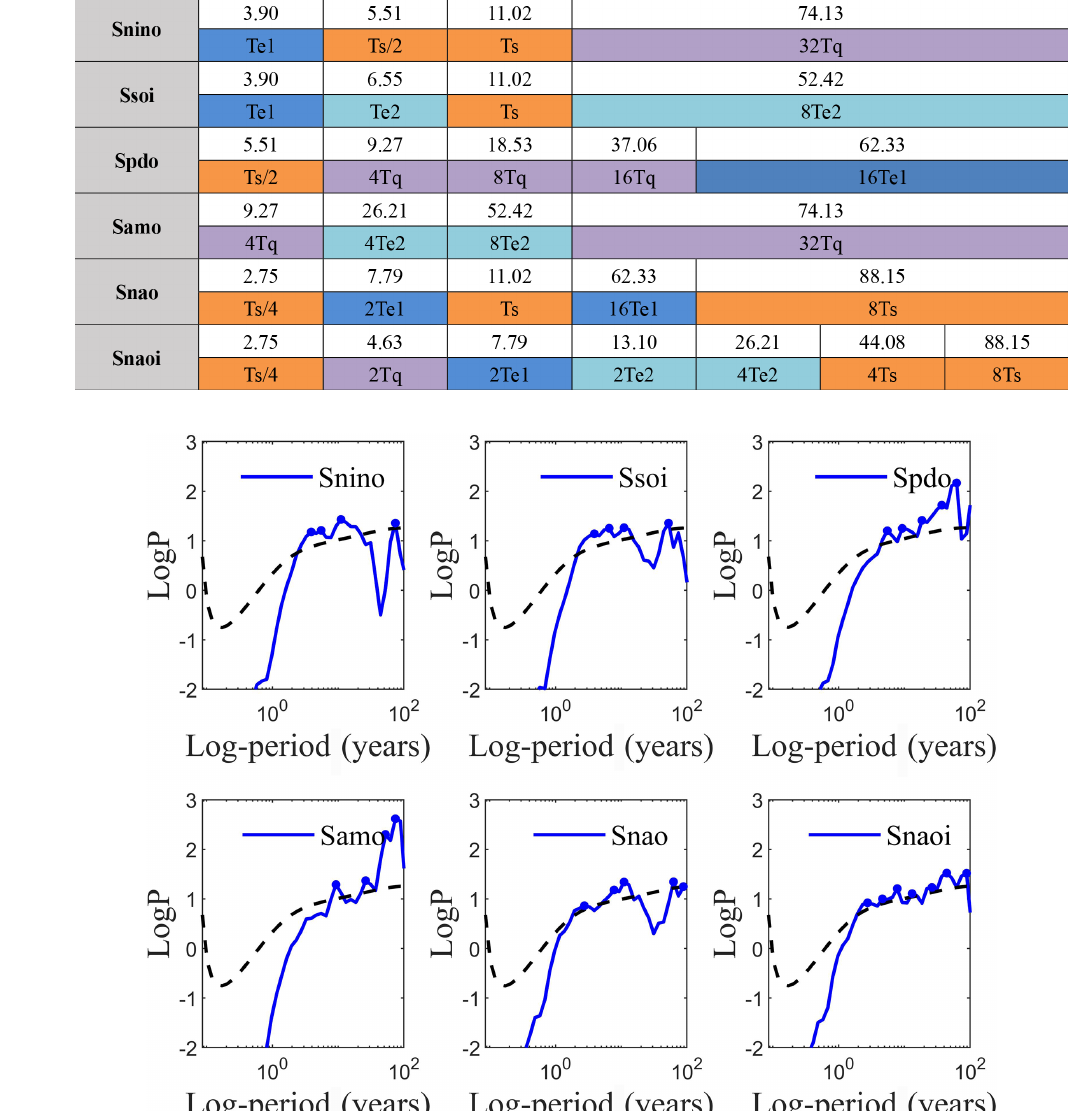
(52.42 years) timescales on the NAO variability. Similar re- sults can be found for other climate